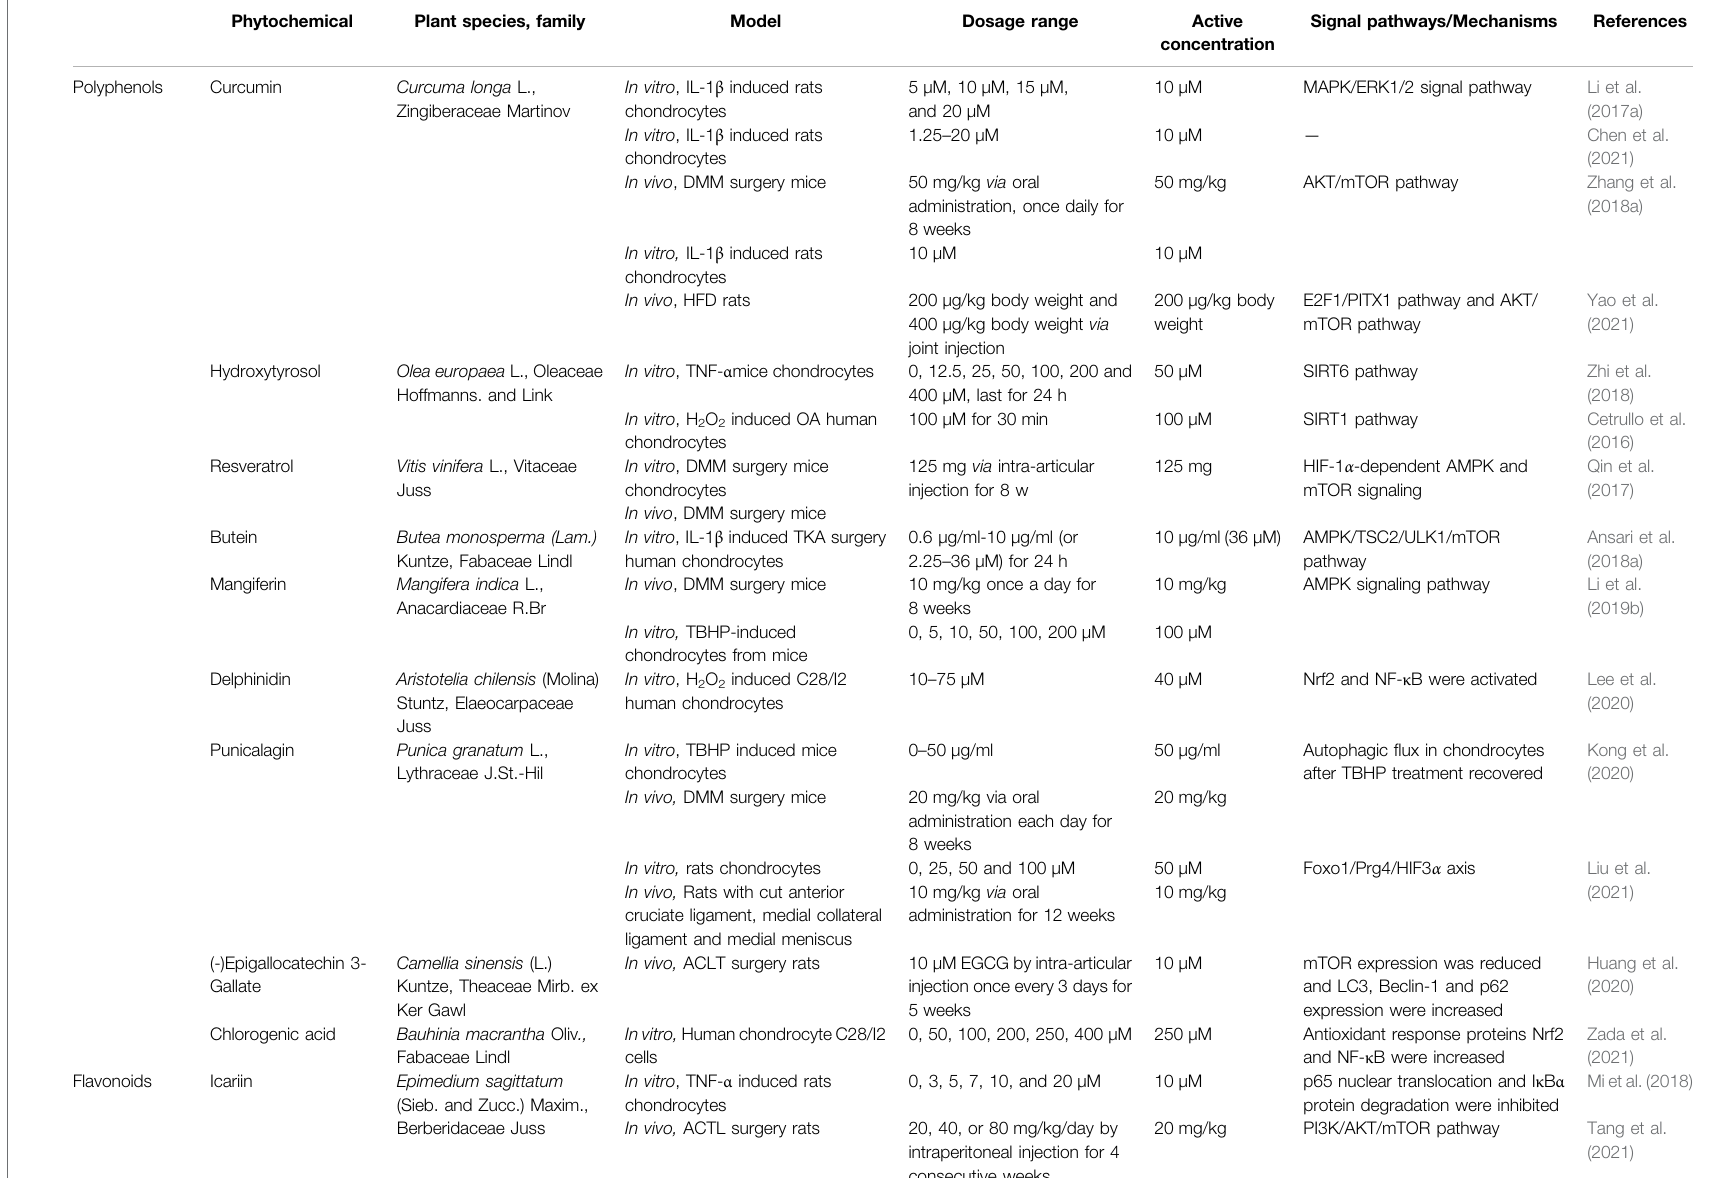
TABLE 1 | Phytochemicals improve cartilage homeostasis via mediated autophagy against OA in vitro/in vivo .